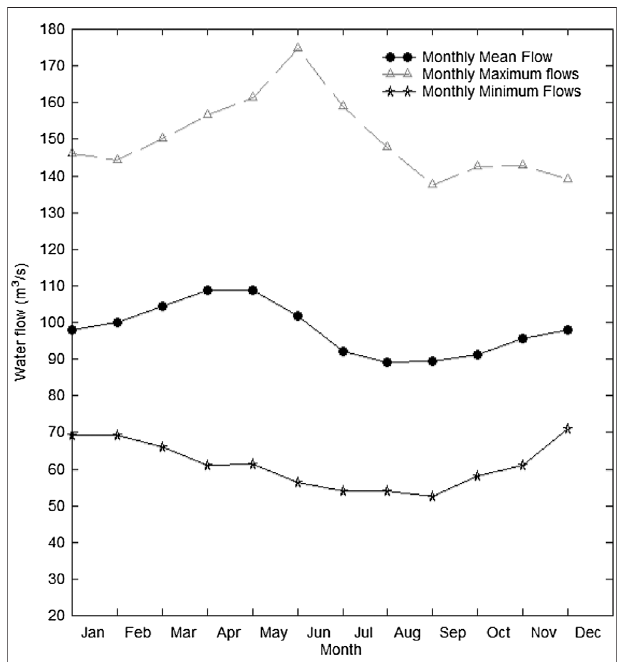
FIGURE 2 | Monthly (natural) water fl ow of the Ruzizi River at its Lake Kivu out fl ow (1941 – 2015).